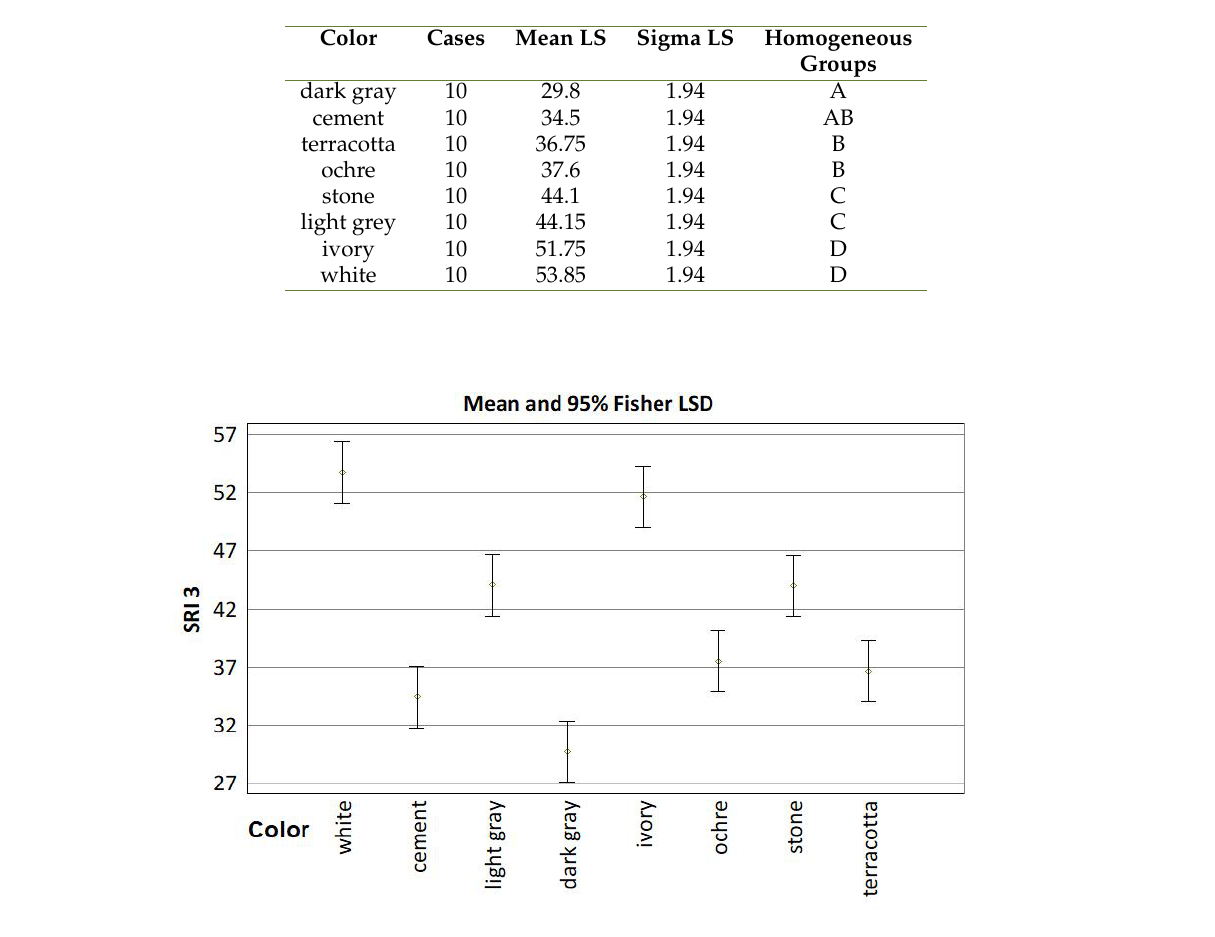
Table 4. Homogeneous groups of the variable color. Method: 95.0 percent LSD. Sources: Author’s own work.